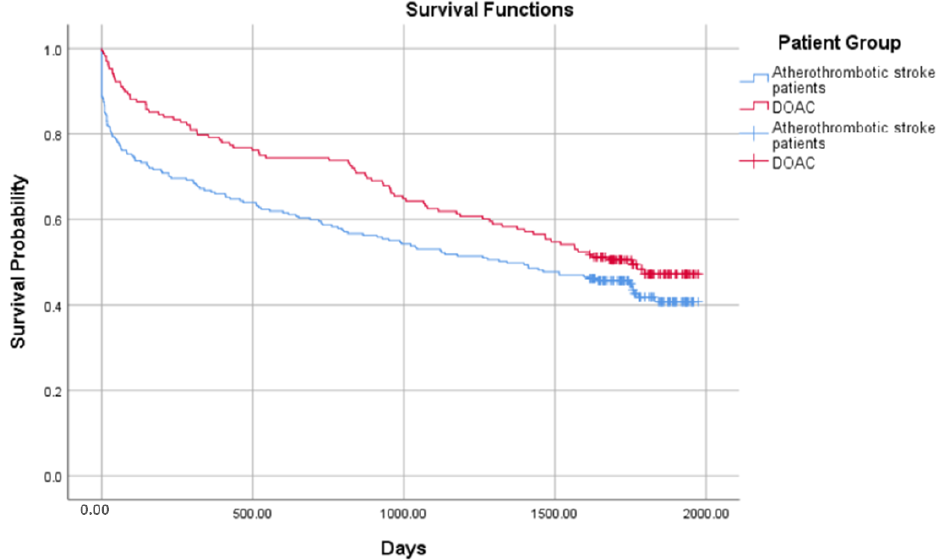
Figure 1. Probability of survival in the atherothrombotic stroke and the cardioembolic stroke groups.